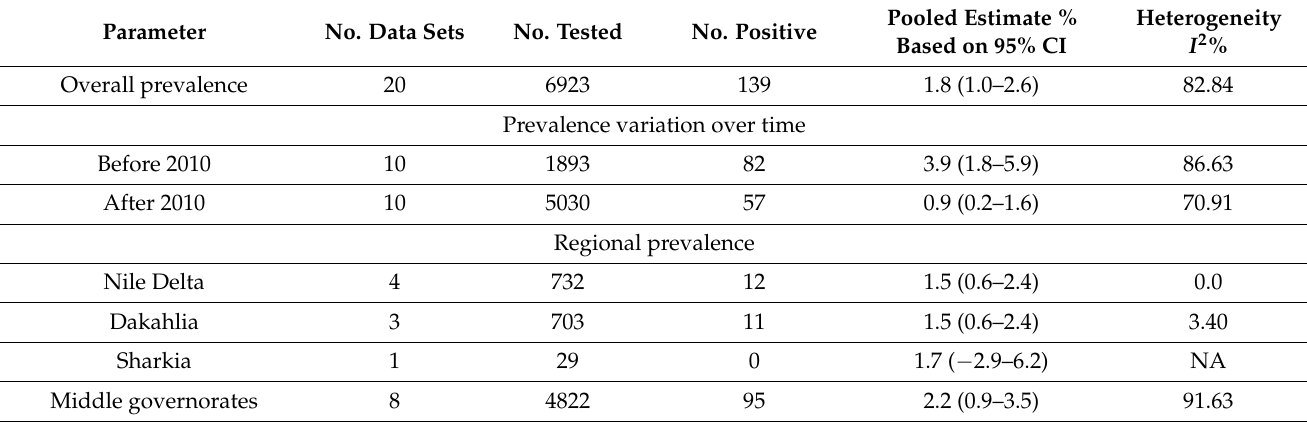
Table 5. Overall and regional pooled prevalence of hookworms in dogs from various Egyptian regions, and variabilities according to dog life